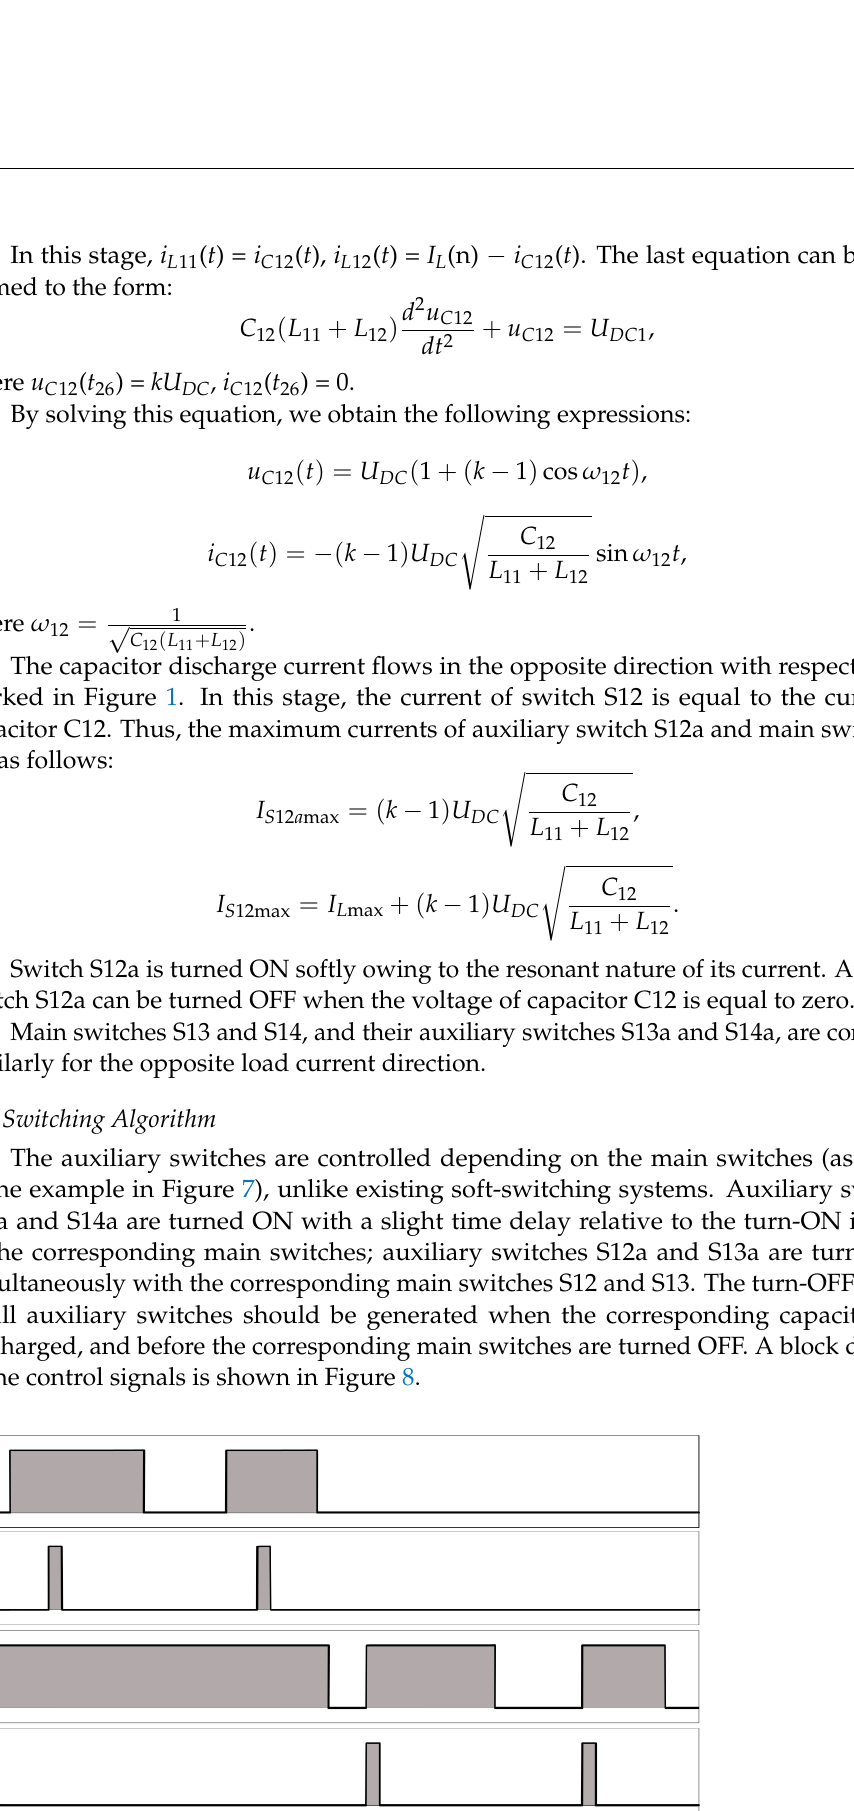
Figure 8. Generation of control signals of switches. The input parameters are entered into the block “Control parameters of hard switched inverter”, which specifies the control parameters. These parameters are entered into the block “Control algorithm of hard switched inverter”, which generates a control signals for the main switches S11, S12, S13 and S14 of a 3LNPC inverter without a soft-switching system. The “Work blocking of switches” is applied to reduce additional losses that may occur in switches S13, S14, S13a and S14a when the switches S11, S12, S11a and S12a are turned ON and turned OFF. The measured instantaneous value i L ( t ) of the load current is compared with assumed threshold currents − I tr and + I tr . When the load current is higher than + I tr , main switches S13 and S14 and their auxiliary switches S13a and S14a are in non-conduction states. In turn, if the load current is lower than the value − I tr , switches S11, S12, S11a and S12a do not change its operating states. In the case when the instantaneous value i L ( t ) of the load current is in the range from − I tr to + I tr , all switches are turned ON and turned OFF. Two “Control unit of auxiliary switches” blocks generate control signals for auxiliary switches depending on the control signals of the main switches. 3. Selection of Inverter Elements 3.1. Selection of Switches The switches in 3LNPC inverters are selected for a single supply voltage U DC . Owing to the working principles of the proposed solution, the switches should be selected for rated voltages higher than the supply voltage U DC . This especially concerns switches S11 and S14, because the maximum voltage of switches S12 and S13 is not higher than twice the value U DC . The turn-OFF process of the main switches has a soft character, given that the maximum voltage of capacitors C11 and C14 should not be less than twice the voltage